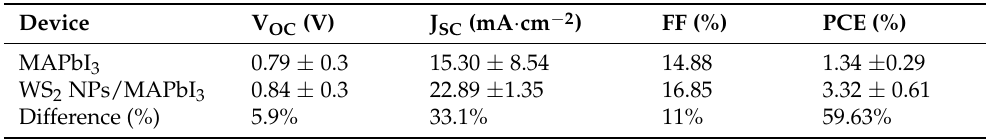
Table 1. Photovoltaic parameters of the devices without (MAPbI 3 ) and with WS 2 NPs (WS 2 NPs/MAPbI 3 ). Device